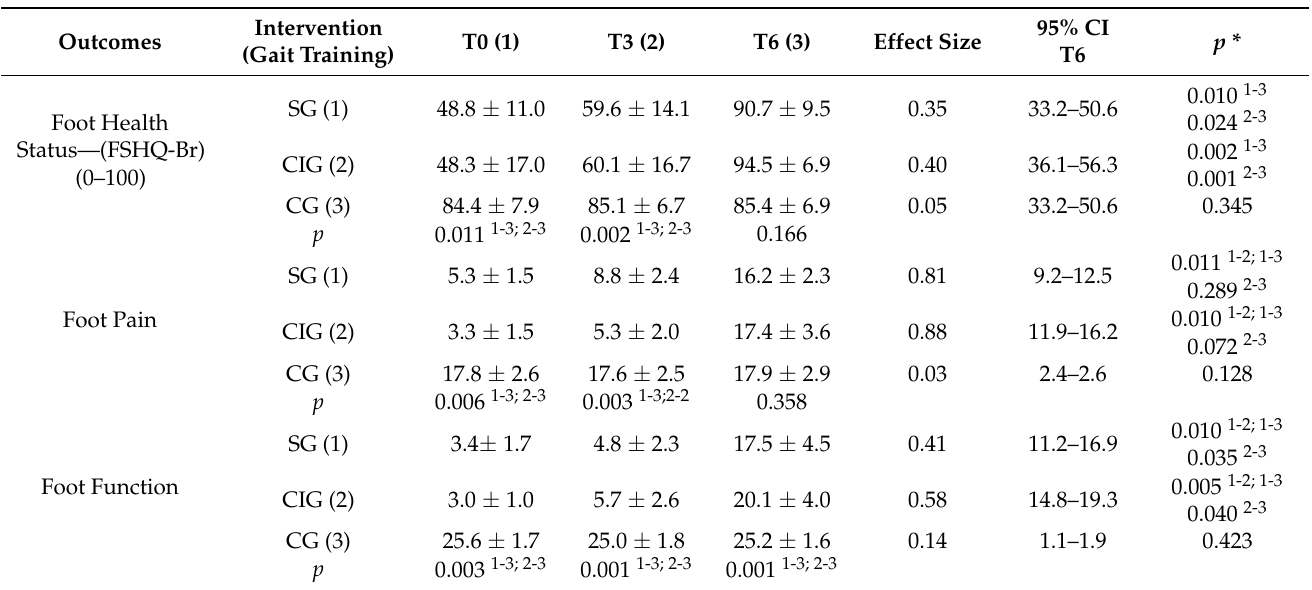
Table 3. Foot Health Status and its domains in the inter-group comparisons: minimalist shoe (SG), custom insole (CIG), and control group (CG), and interventions: T0 (baseline) and after T3 and T6 months of intervention in women with plantar fasciitis